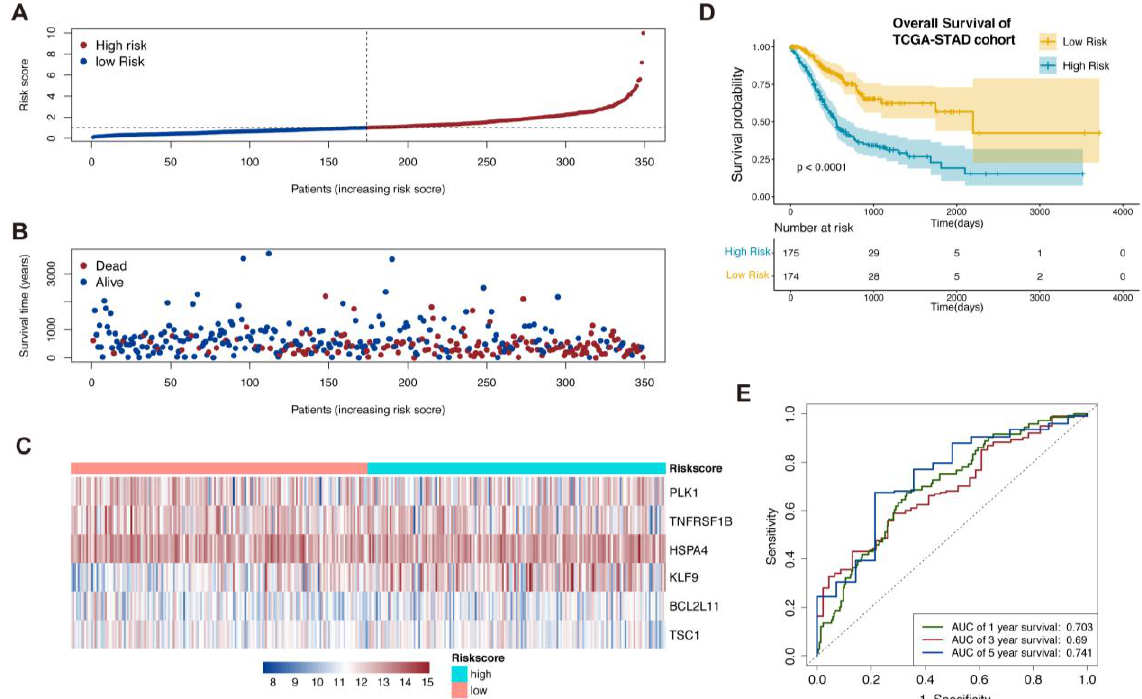
Figure 1. Establishment of necroptosis-related prognostic signature. ( A ) TCGA-STAD patients sorted by risk score. ( B ) The correlation between the patient’s prognosis and the risk score. ( C ) A heatmap of expression levels of the 6 genes in prognostic signature. ( D ) Kaplan–Meier survival analysis of TCGA-STAD patients between low-risk and high-risk groups. ( E ) Time-dependent ROC analysis of necroptosis-related prognostic signature.